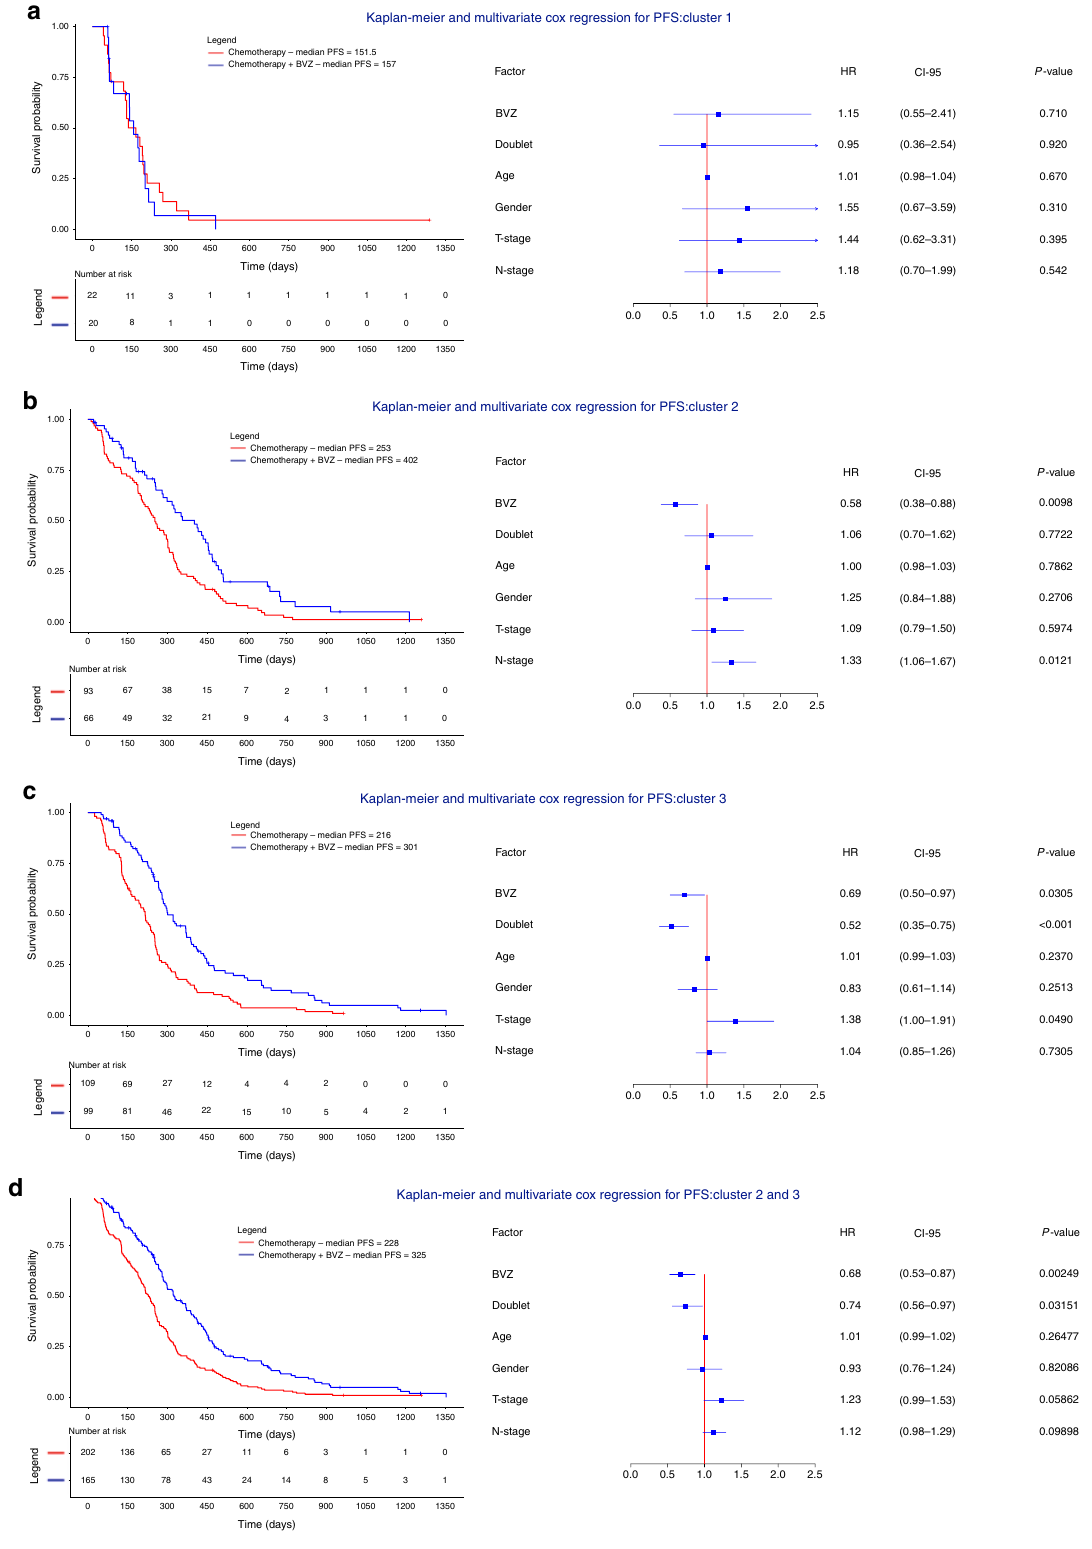
Fig. 4 Multivariate Cox regression assessing the effect BVZ while stratifying for CNA cluster membership. a – d Kaplan-Meier plots and multivariate Cox regression with hazard ratios, 95% con fi dence intervals and P-values are shown while correcting for the relevant covariates in mCRC receiving chemotherapy + BVZ while stratifying for CNA cluster 1 ( a ), cluster 2 ( b ), cluster 3 ( c ) and cluster 2 + 3 versus cluster 1 ( d ). Effects were only signi fi cant for the latter 3 comparisons. Doublet stands for mono-chemotherapy (FP) or a combination of chemotherapy (FP-OX,